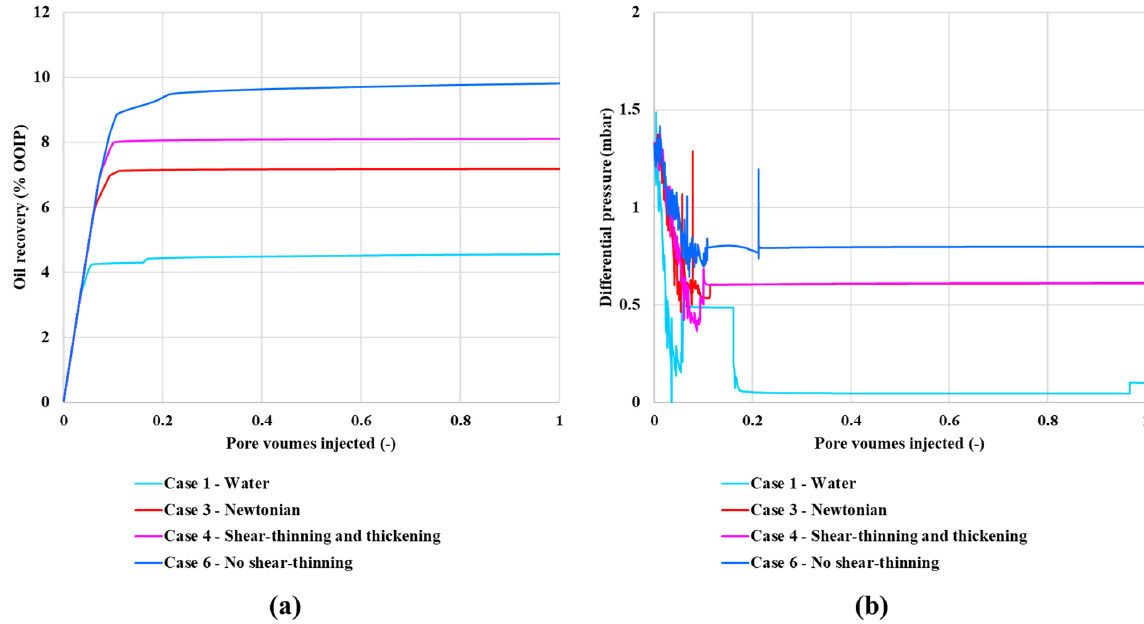
Figure 14. ( a ) Oil recovery and ( b ) differential pressure for pore network modelling with an injection rate of 1 × 10 − 13 m 3 /s as a function of pore volumes.